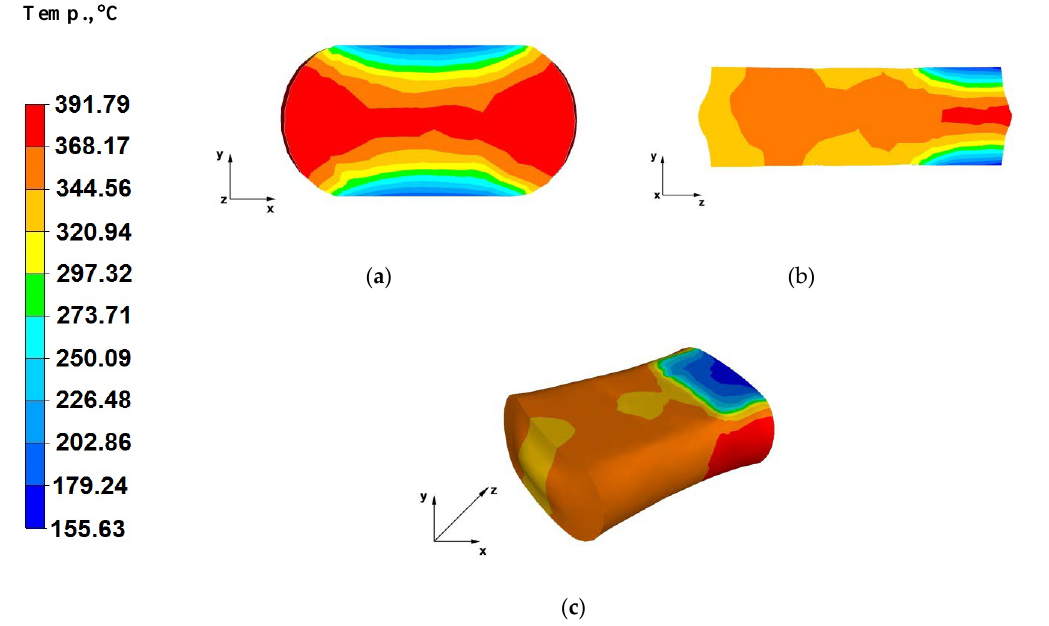
Figure 8. ( a ) Temperature distribution over the cross-section of an AZ91 alloy forging deformed within the third pass, with a relative reduction of 40%, in flat dies; ( b ) Temperature distribution over the longitudinal section of an AZ91 alloy forging deformed within the third pass, with a relative reduction of 40%, in flat dies; ( c ) Axonometric view of the temperature distribution over the surface of an AZ91 alloy forged within the third forging pass, with a relative reduction of 40%, in flat dies.